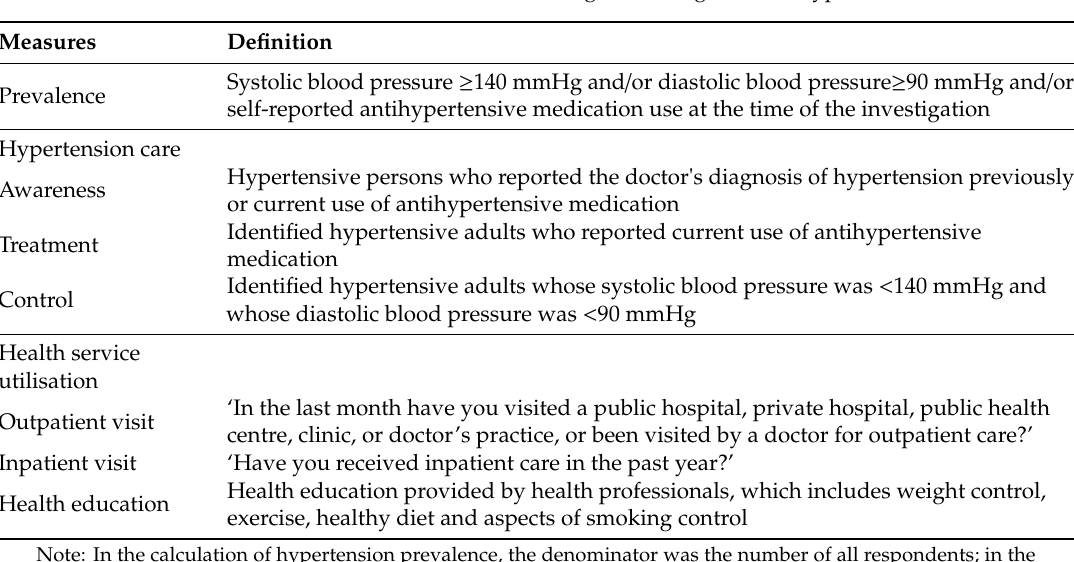
Table 1. Definition of indicators for evaluating the management of